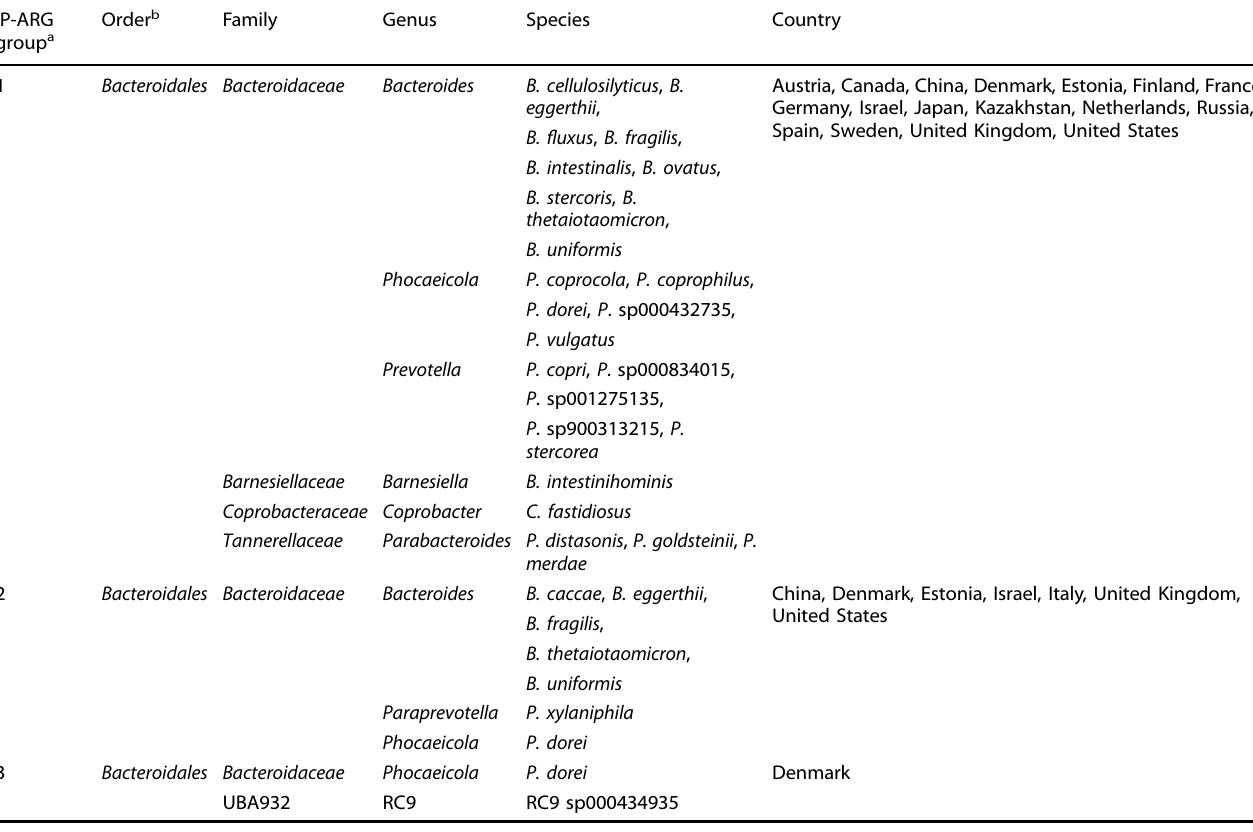
Table 1. Taxonomic and geographic distribution of ARGs regulated by invertible